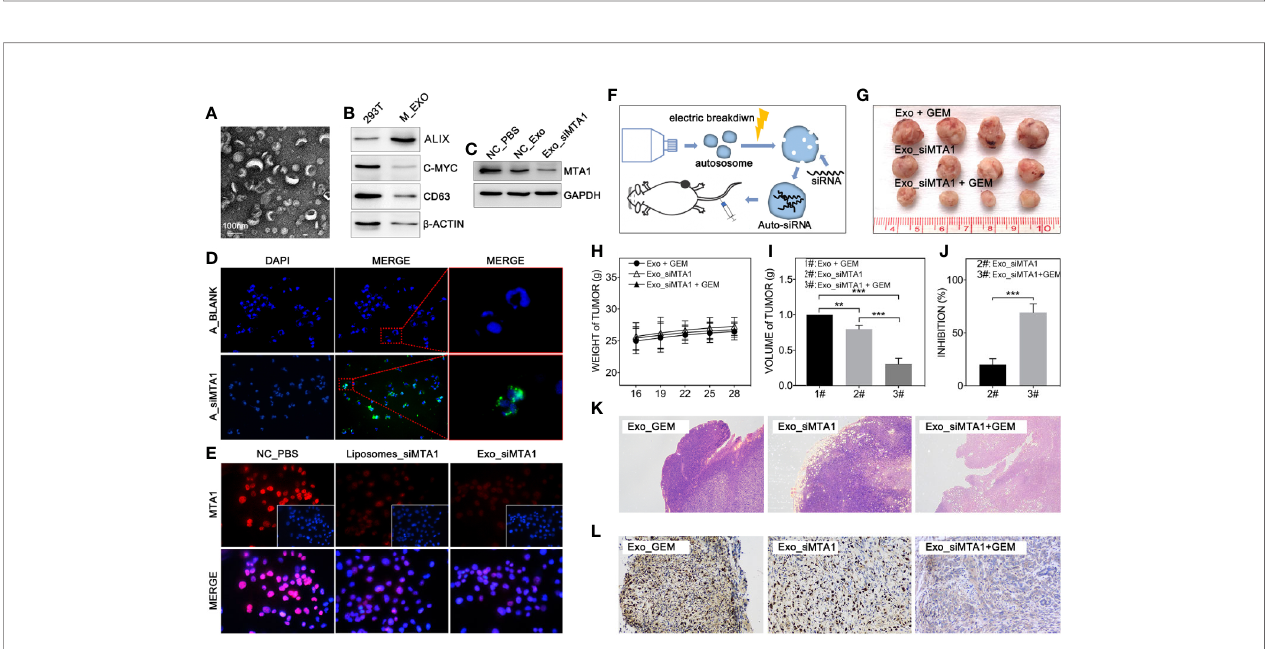
FIGURE 5 | MTA1 loaded exosomes enhanced gemcitabine mediated tumor growth inhibition in vivo . (1) Electron microscopy of exosomes (A) . (2) WB assay tests markers of exosomes (B) . (3) WB assay for MTA1 knockdown ef fi ciency by siMTA1-loaded exosomes (Exo_siMTA1) (C) . (4) Immuno fl uorescence (IF) assay for up taking of siMTA1-loaded exosomes by MCF-7 cells (D) . (5) IF assay tested MTA1 knockdown ef fi ciency by siMTA1-loaded liposomes (LIP_siMTA1) and Exo_siMTA1 (E) . (6) Experiments process in vivo (F) . (7) Tumor volume (1#: Exo + GEM, 2#: Exo_siMTA1, 3#: Exo_siMTA1 + GEM) (G, I) . (8) Weight of mouse (H) . (9) (J) Tumor growth inhibition rate (2#: Exo_siMTA1, 3#: Exo_siMTA1 + GEM). (10) H&E staining (K) and ki-67 staining (L)